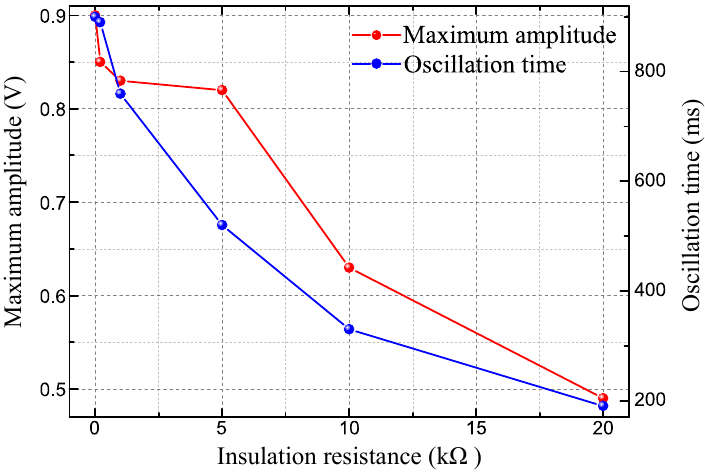
Figure 21. Zero-sequence voltage change with respect to insulation resistance.